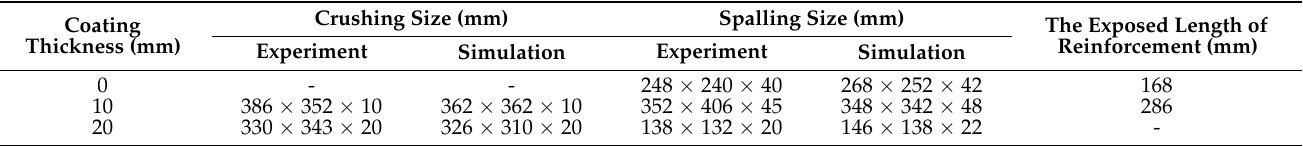
Table 7. Damage parameters of foamed concrete-coated RC